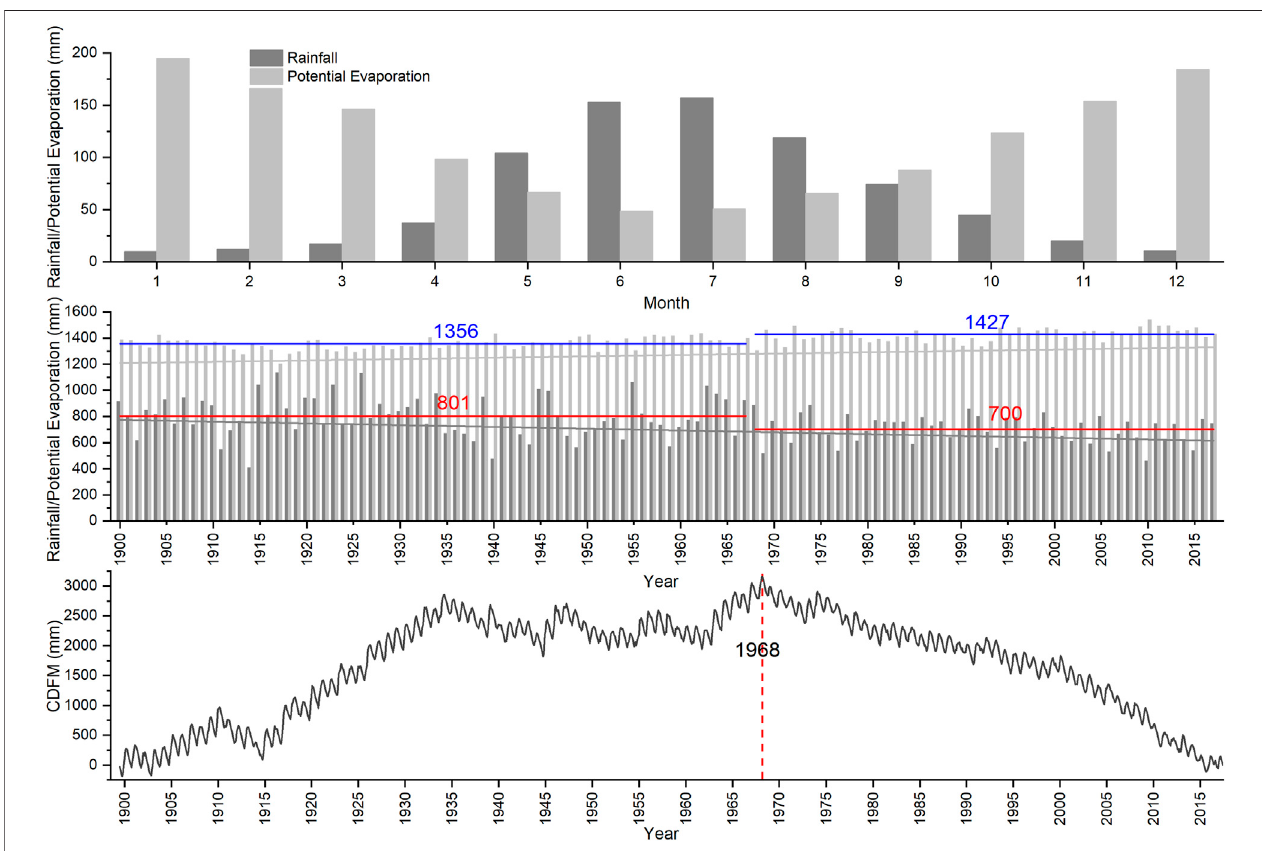
FIGURE2| Long-termaveragesofthemonthlyrainfall,annualrainfallandpotentialevapotranspiration,anddryclimaticperiodsbycumulativedeviationfrommean rainfall (CDFM) in the Gnangara region.